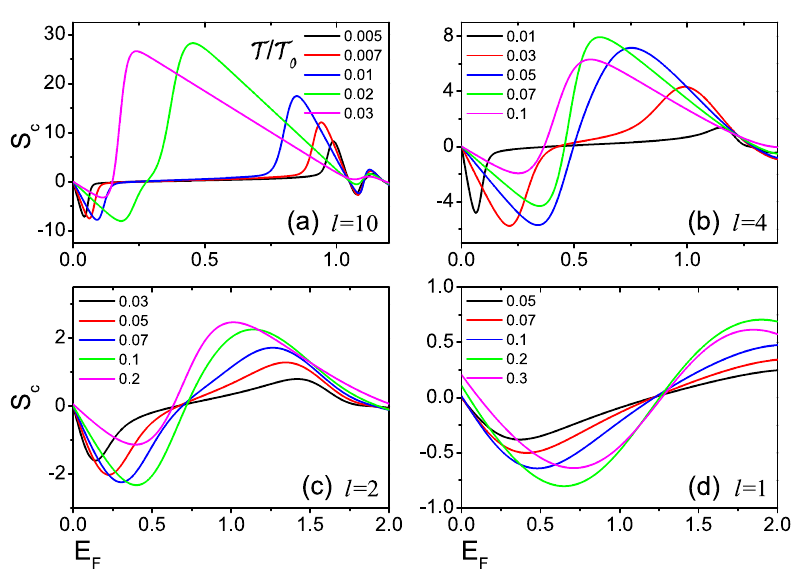
Figure 5. The Seebeck coefficients S c as functions of Fermi energy E F for different temperatures T / T 0 with π . The temperatures are expressed in units of T 0 = ε relative tilt φ = = 10 in ( a ), and l = 4 in ( b ), and l = 2 in ( c ) and l = 1 in ( d